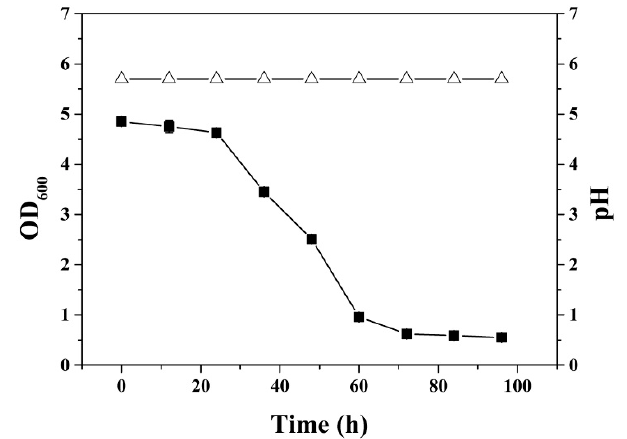
Figure 5. Growth curve of the mutant C. acetobutylicum glcG ::int(1224) ‐ glcCE ::int(193) in phosphate ‐ limited continuous culture. ( △ ), pH; and ( ■ ), OD 600 of glcG ::int(1224) ‐ glcCE ::int(193).